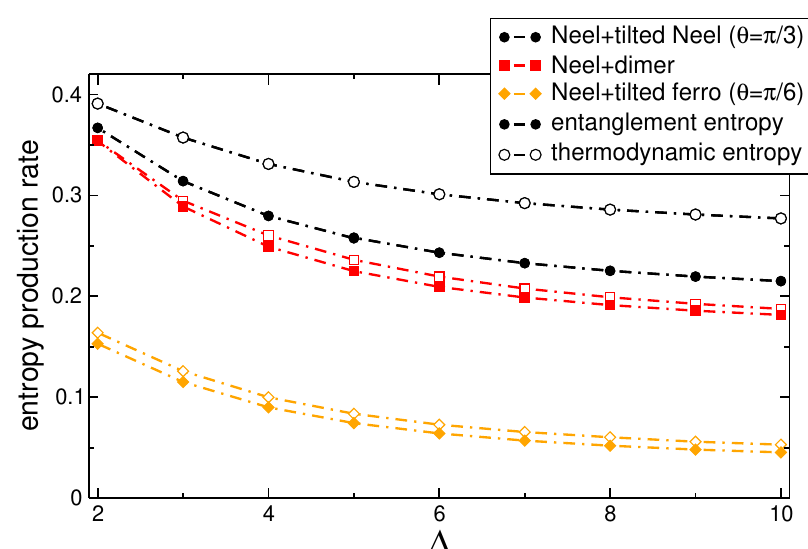
Figure 6: Entanglement (full simbols) versus thermodynamic (empty symbols) en- tropy production rate after the quench from a piecewise homogeneous initial state in the XXZ chain. The x -axis shows that chain anisotropy. Different symbols are used for different initial states obtained by joining the tilted Néel state (24), the dimer state (23), and the tilted ferromagnetic state (25). Full symbols are obtained using Eq. (88) while empty symbols are obtained using Eq.